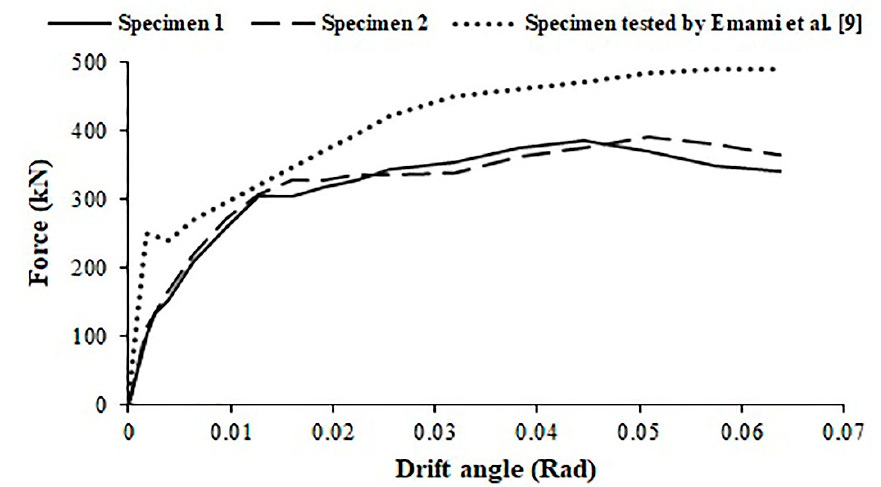
Figure 13. Force-drift angle curves of studied specimens.